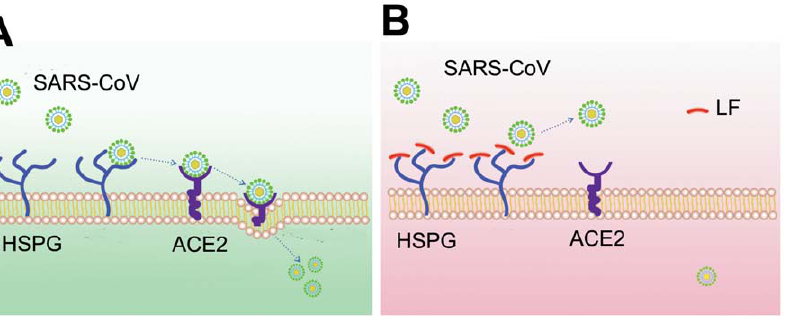
Figure 9. A model of SARS-CoV cell entry and the protective role of Lactoferrin in SARS-CoV infection. ( A ) HSPGs play an important role in the process of SARS-CoV cell entry. The anchoring sites provided by HSPGs permit initial contact between SARS-CoV and host cells and the concentration of virus particles on cell surface. SARS-CoV rolls onto the cell membrane by binding to HSPGs and scans for specific entry receptors, which leads to subsequent cell entry. ( B ) LF blocks the infection of SARS-CoV by binding to HSPGs. LF expression may be up-regulated when SARS- CoV infects the human body. LF locates to cell-surface HSPGs and prevents the preliminary interaction between the virus and host cells and the subsequent internalization